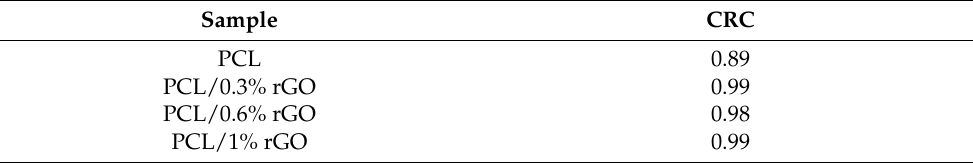
Table 3. Crystallization rate coefficient (CRC) parameter for the scaffolds under study.